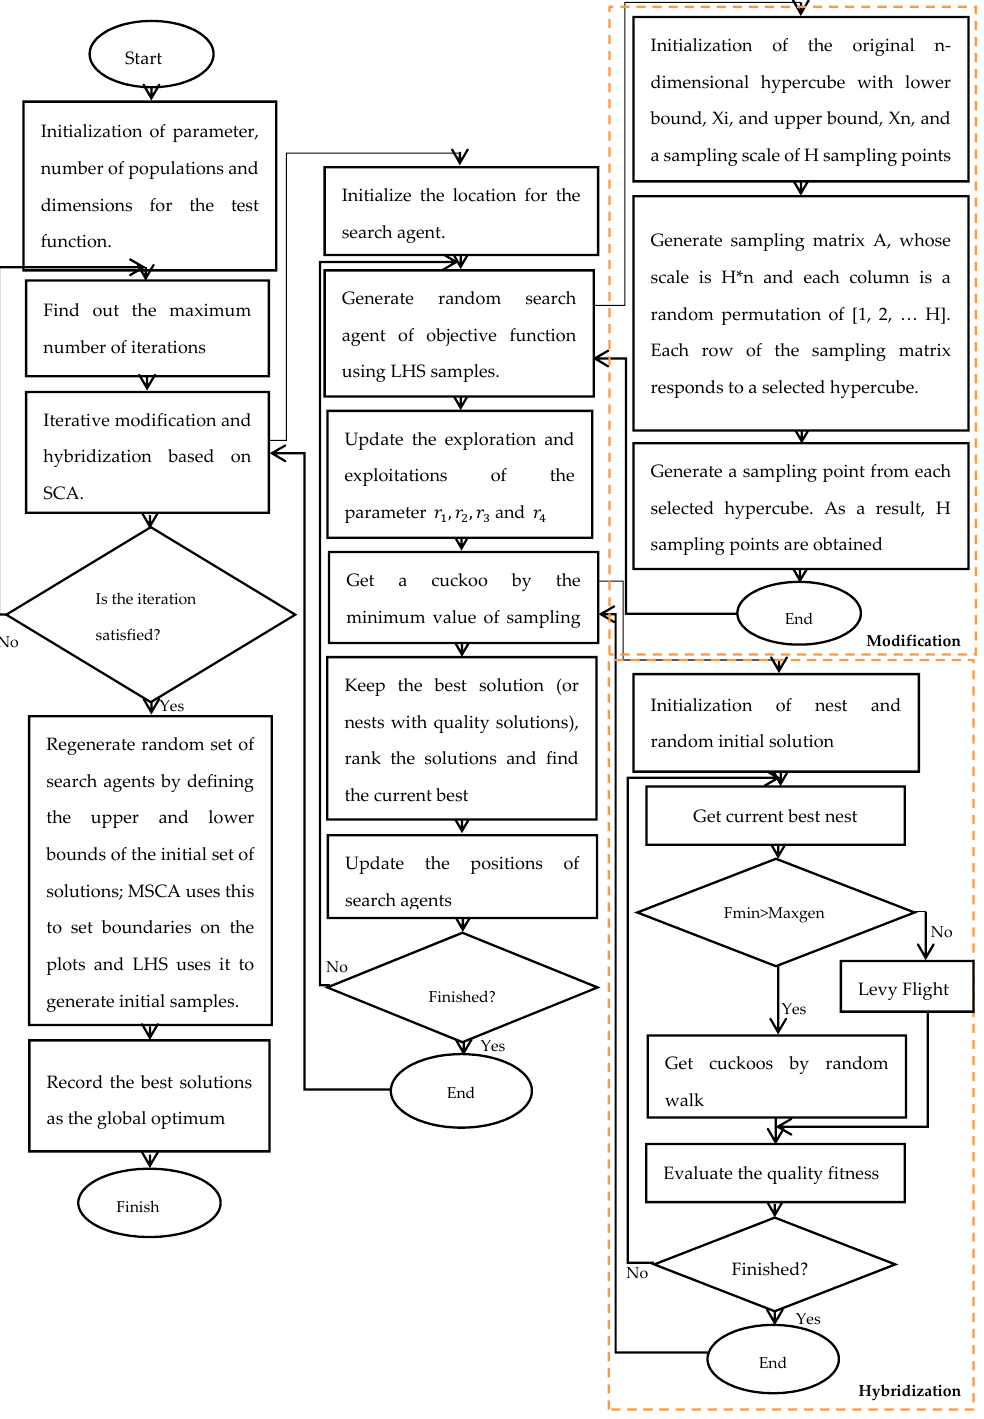
Figure 4. Flowchart of the hybridization and modification for the proposed method based on the SCA.